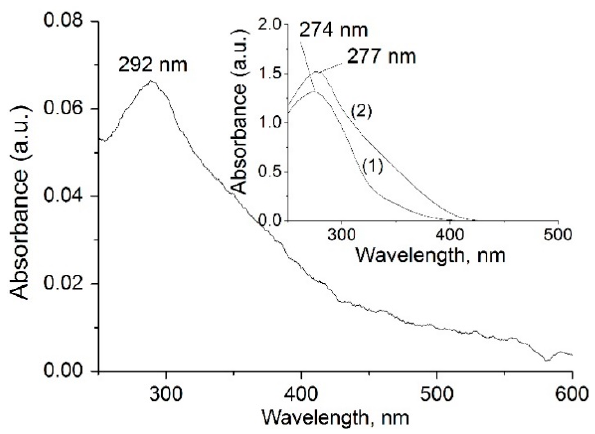
Figure 9. Reflection ‐ absorption spectrum of thiacalix[4]arene 2b at the air–water interface at the surface pressure of 11 mN/m (inset, UV/Vis spectrum in ( 1 ) CHCl 3 and ( 2 ) CHCl 3 :MeOH = 85:15).